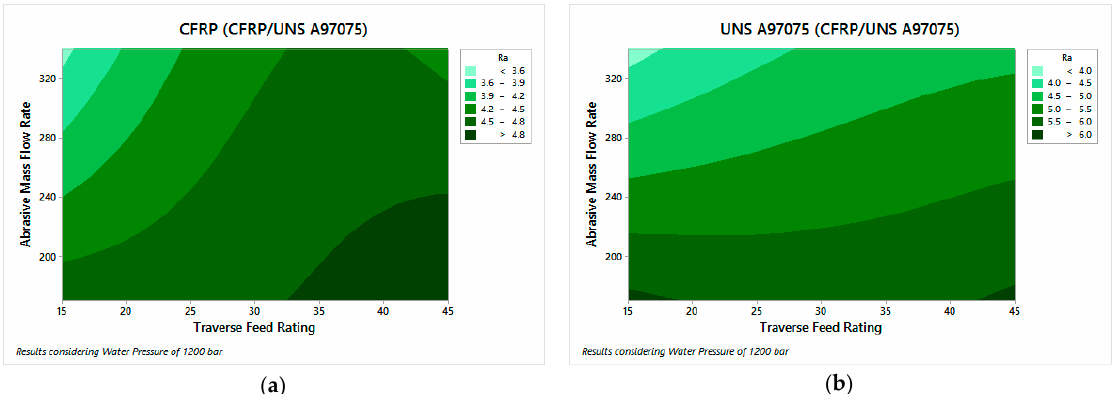
Figure 13. Roughness for CFRP/USN A97075 configuration: ( a ) CFRP and ( b ) UNS A97075.